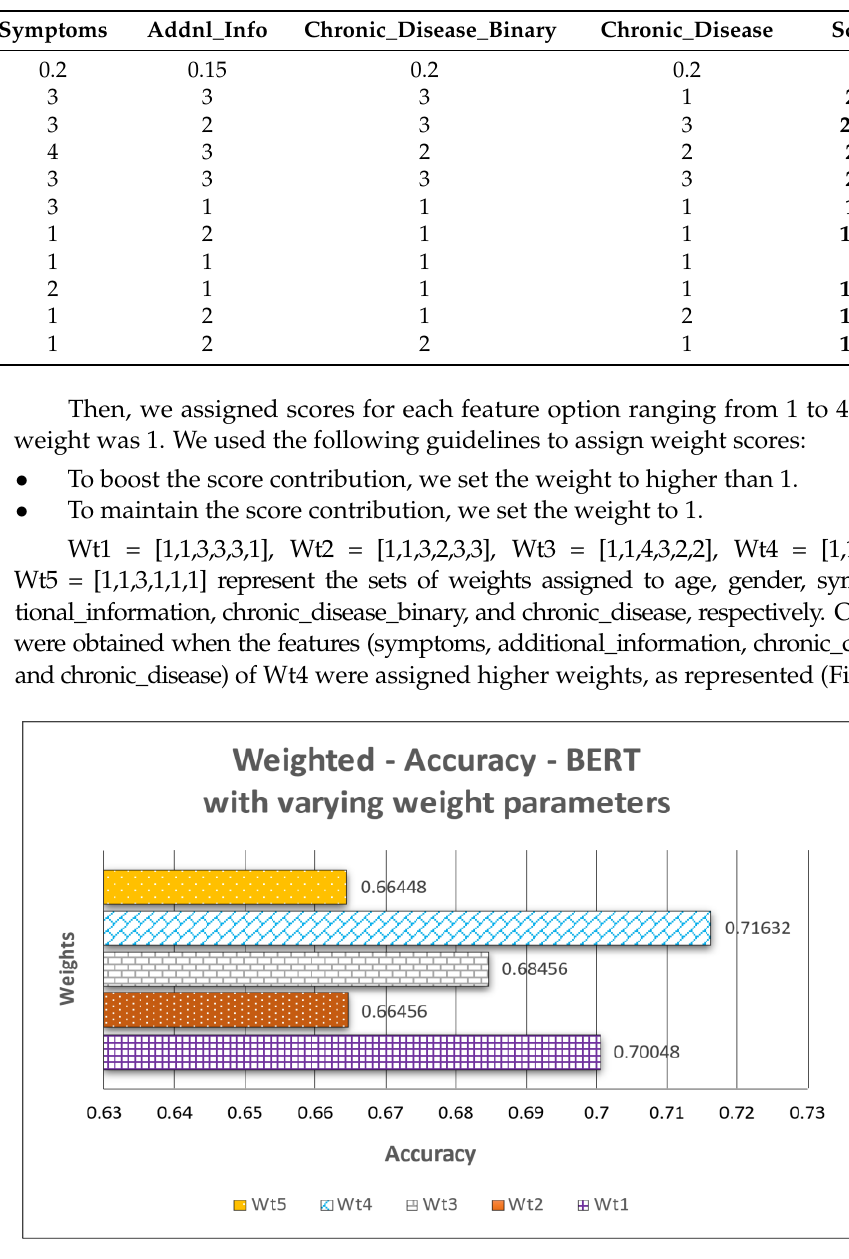
Figure 6. Weighted accuracy based on weighted features.